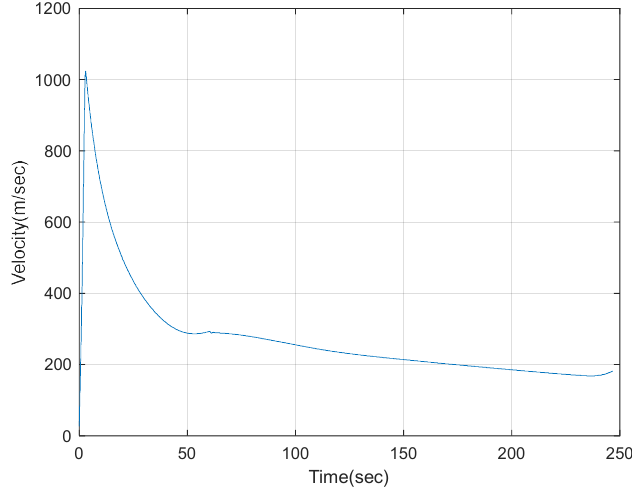
Figure 17. Velocity Plot.